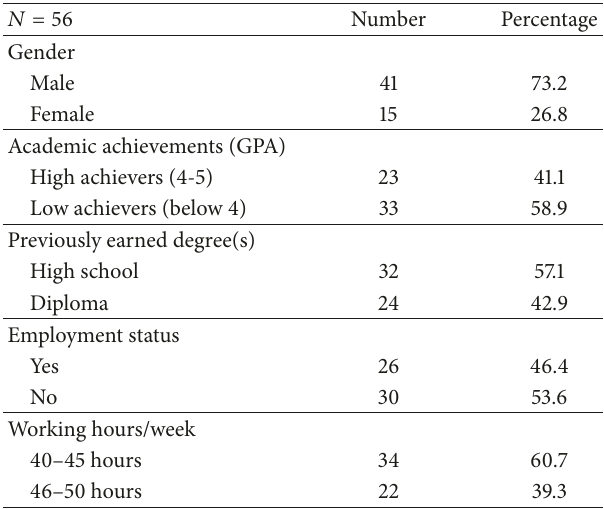
Table 1: Participant’s characteristics.